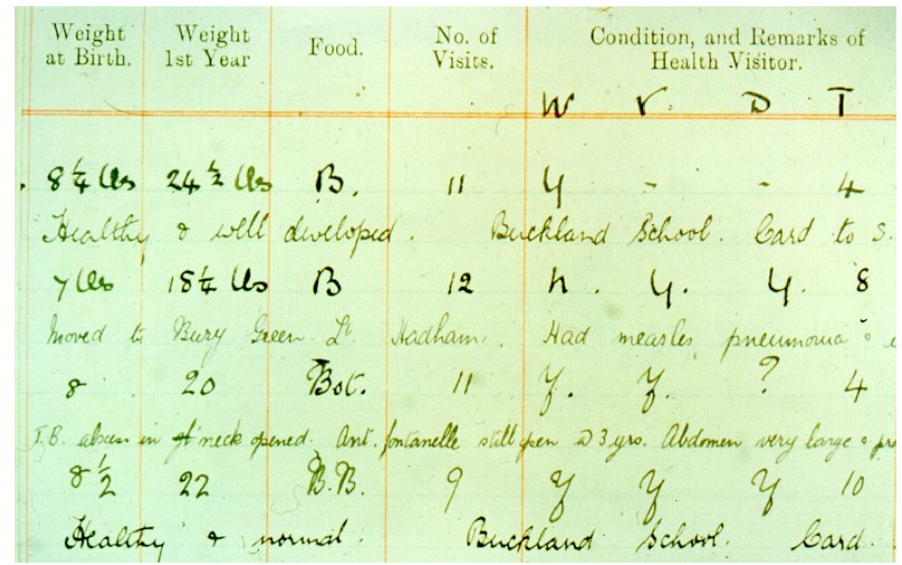
Figure 1. An extract from the Hertfordshire ledgers. Source: original Hertfordshire ledger, on loan from the Hertfordshire Local Studies Archive; currently stored securely at the MRC